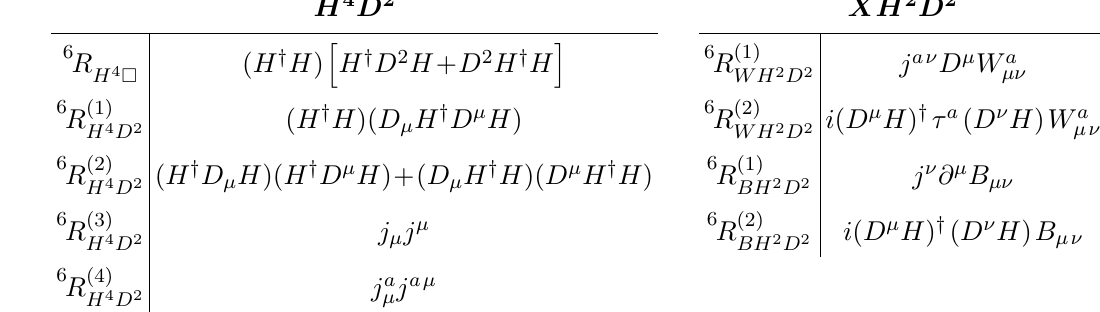
Table 5 . Redundant bosonic dimension-six operators in the